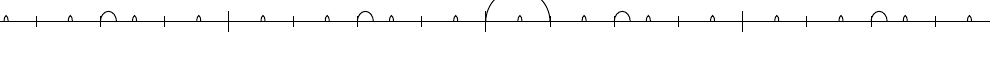
Figure 1: The shortcuts S 1 , S 2 and S 3 in [0, 1] for l = 2, h = 1/4